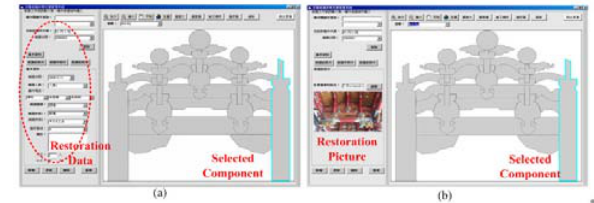
Fig. 14. Restoration information (a); restoration pictures (b)